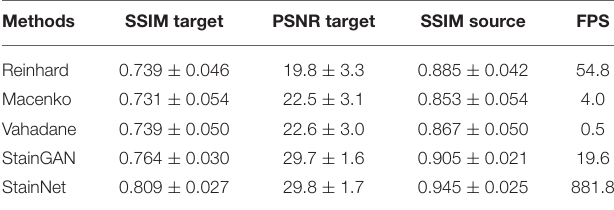
TABLE 2 | Evaluation metrics of various stain normalization methods on the histopathology